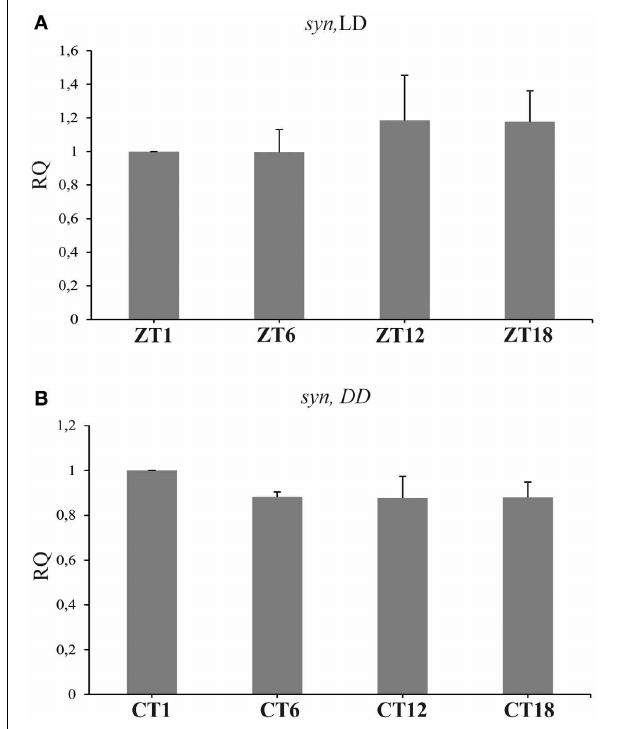
FIGURE 3 | The level of BRP-specific immunofluorescence intensity (brightness) in the fly’s lamina after locomotor (A) and light (B) FIGURE 4 | The relative level of syn mRNA in the brain of flies raised in